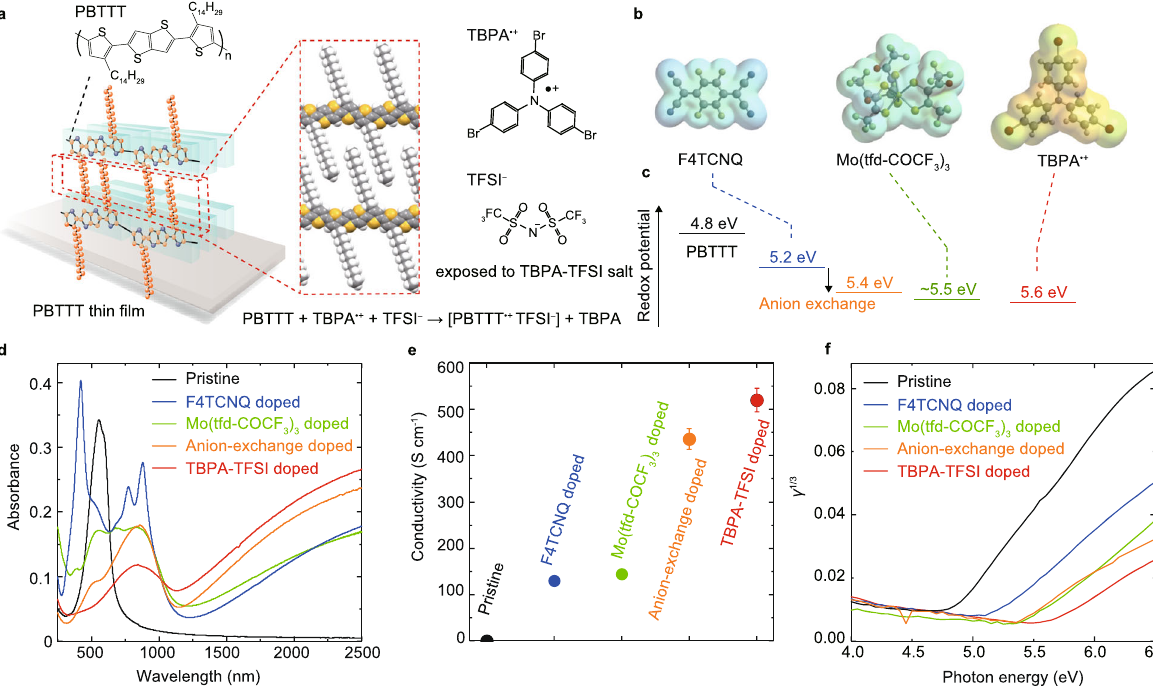
Fig. 1 Comparison of chemically doped PBTTT thin fi lms with conventional and newly developed dopants. a Illustration of chemical doping of a PBTTT thin fi lm. b Chemical structures of employed dopants and ( c ) their reported redox potentials accompanied with the approximate valence band top of PBTTT. d UV-Vis-NIR spectra, e conductivities, and ( f ) photoelectron yield spectroscopy measurements for pristine (black), F4TCNQ (blue), Mo(tfd- COCF 3 ) 3 (green), Li-TFSI via anion-exchange (orange), and TBPA-TFSI (red) doped PBTTT thin fi lms. The error bars in the conductivities represent the uncertainty in the thickness of the PBTTT thin fi lms and represent one standard